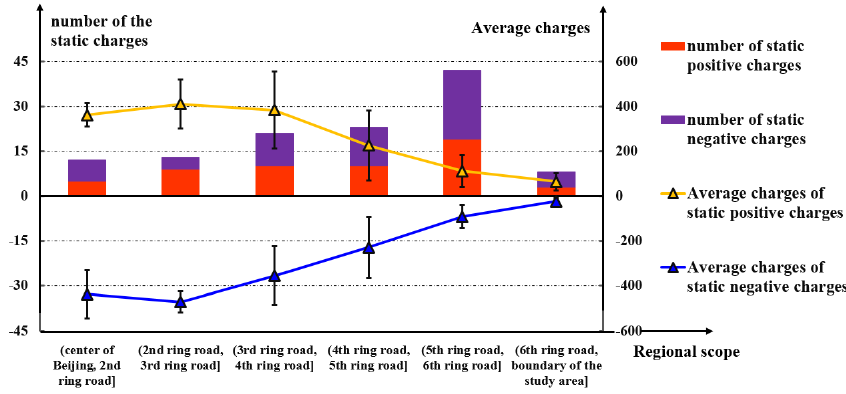
Figure 6. The characteristics of static positive charges and static negative charges in different regions of the study area.